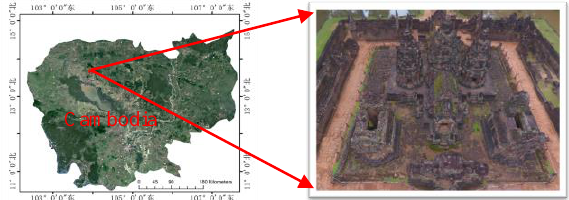
Figure 1. Banteay Srei